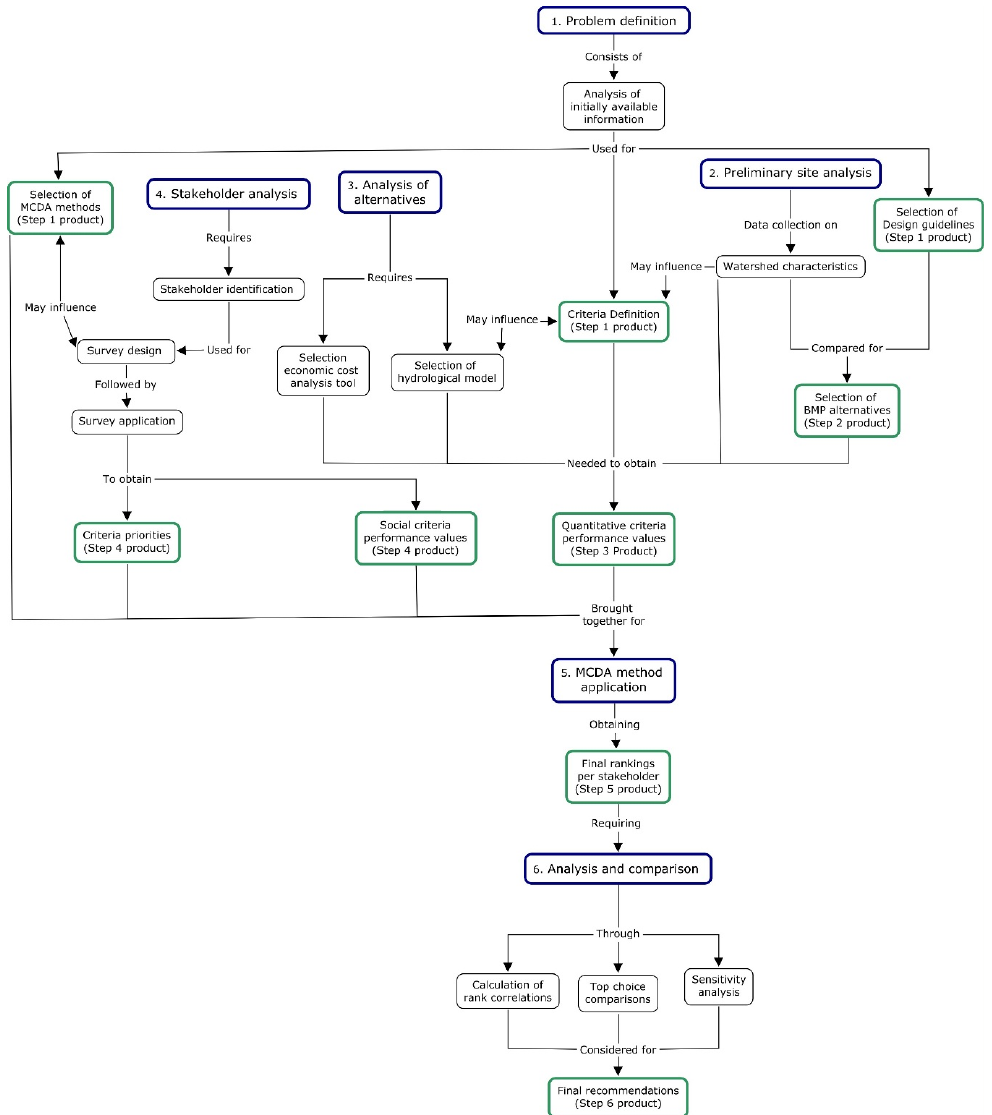
Figure 1. Exchange of information in the proposed methodology.